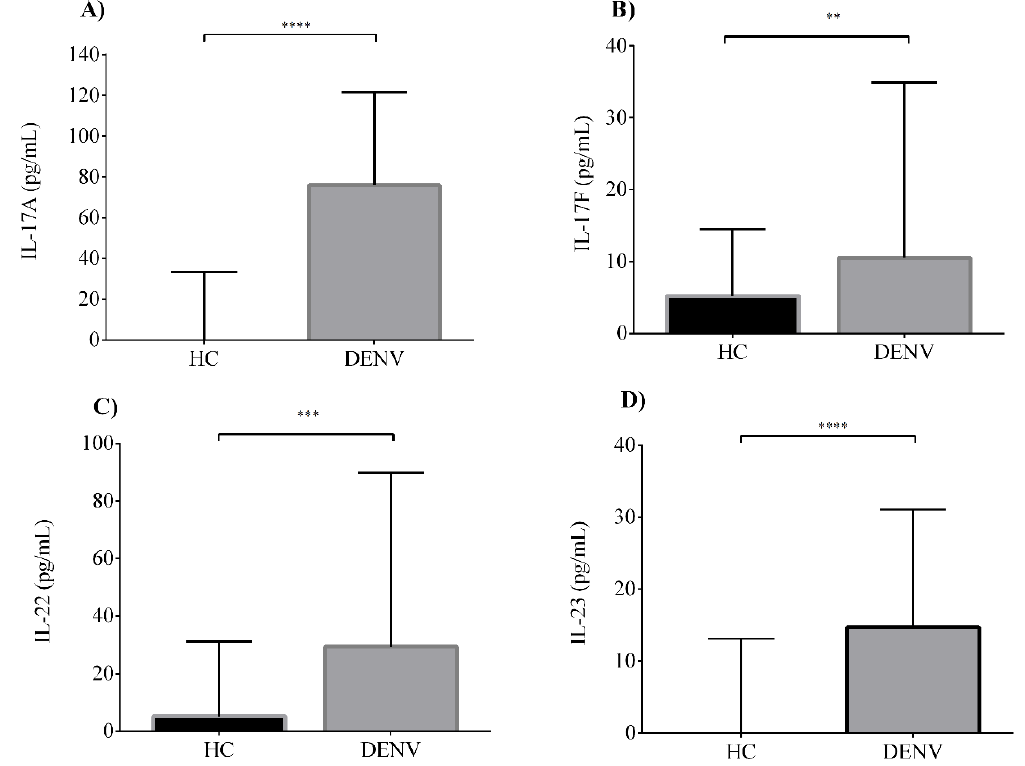
Figure 1. Elevated serum levels of interleukin 17A (IL-17A), IL-17F, IL-22 and IL-23 are produced in dengue infections. Serum levels of ( A ) IL-17A, ( B ) IL-17F, ( C ) IL-22 and ( D ) IL-23 in healthy controls (HC) ( n = 78) compared with dengue virus (DENV)-infected patients ( n = 128). Individual data are shown and the horizontal line is the median value. Statistical difference is based on the Mann– Whitney test. ** p < 0.01, *** p < 0.001, **** p < 0.0001.